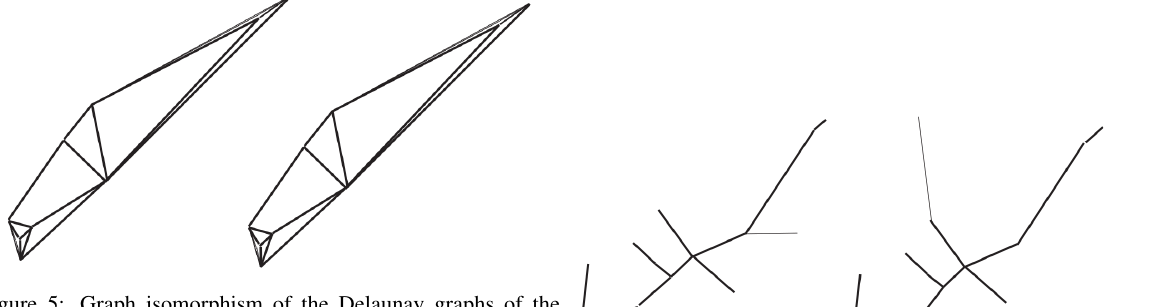
Figure 5: Graph isomorphism of the Delaunay graphs of the matched points on both World View and SPOT6 patch number seven for distance threshold of 3. The two graphs, if assumed without their geometric embeddings, are identical proving that the points are distributed in the same way in the two images.